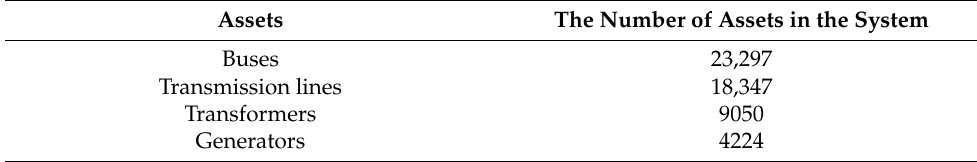
Table 2. The details of the test system.